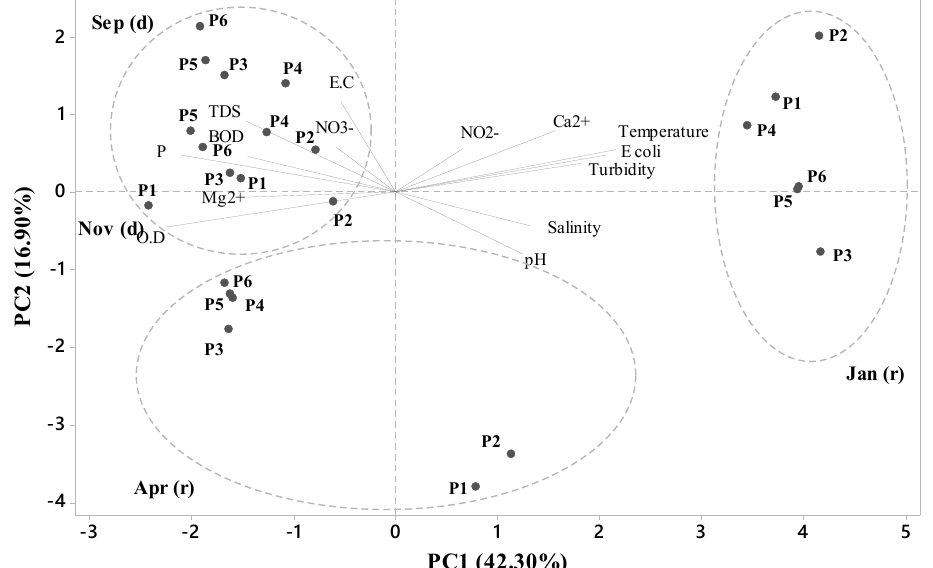
Figure 4. Loading and score plots of all parameters and season studied. (r)-rainy season, (d)-dry season. E.C (electrical conductivity), TDS (total dissolved solids), NO 2 − (nitrite), NO 3 − (nitrate), P (total phosphorus), Mg (magnesium), Ca (calcium), D.O (dissolved oxygen), and BOD (biochemical oxygen demand).